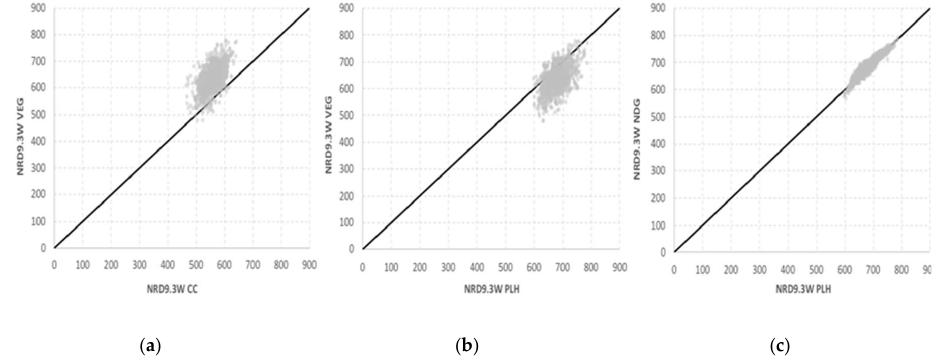
Figure 4. Direct comparison of the nutritional indices obtained from the Monte Carlo analysis: ( a ) VEG diet vs. CC diet; ( b ) VEG diet vs. PLH diet; and ( c ) NDG diet vs. PLH diet.